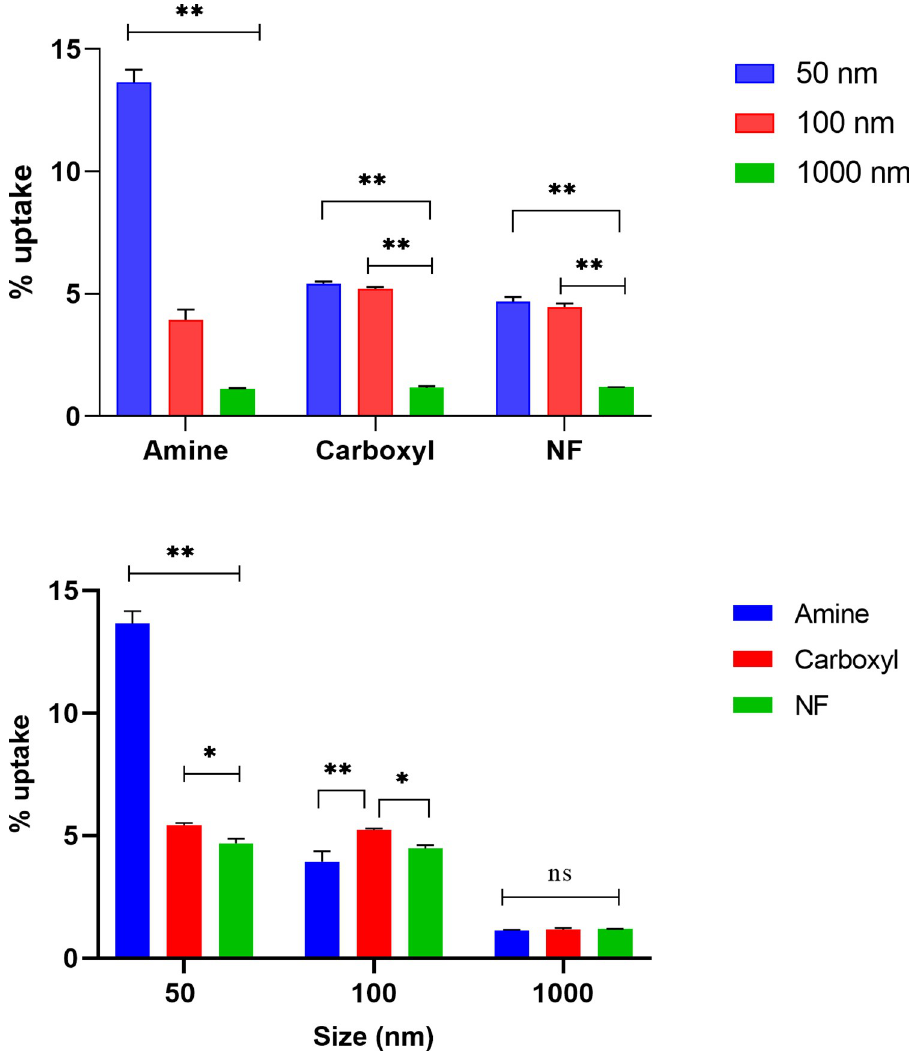
Fig 1. Percent cellular uptake of different sized and surface functionalized polystyrene particles. The uptake of 50, 100 and 1000 nm aminated, carboxylated and NF polystyrene particles by SNU-1 cells were quantitated after 4 h treatment and compared with respect to surface functionalization (A) or particle size (B). All data represented as mean ± S.D. (n = 3). Statistically significant differences are represented by � and �� at p < 0.05, and 0.0001, respectively; ns represents no significant